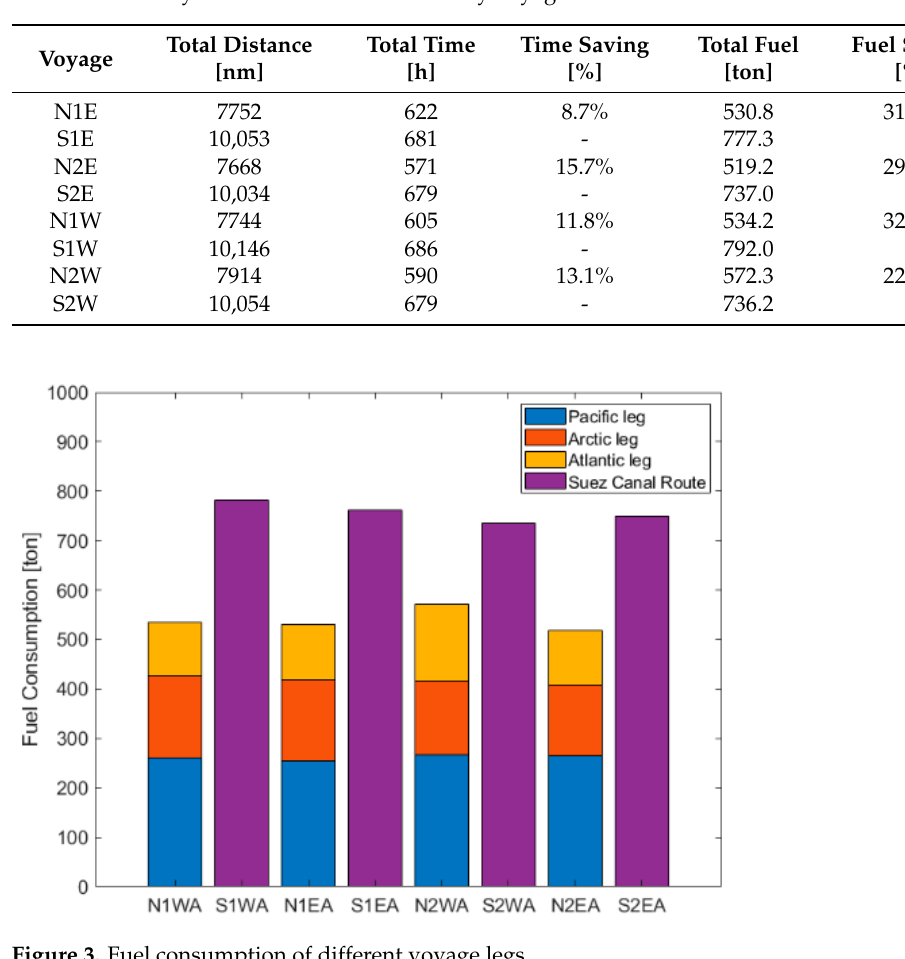
Figure 3. Fuel consumption of di ff erent voyage legs.